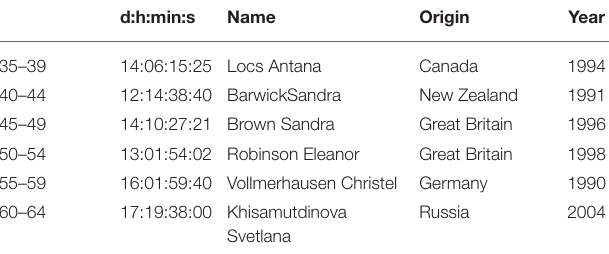
TABLE 2 | World records in female elite and age group athletes in distance-limited races, from